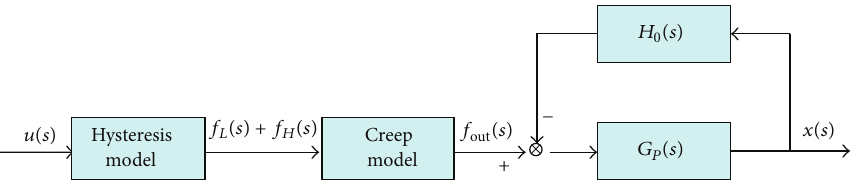
Figure 12: Block diagram of the comprehensive model for prestressed